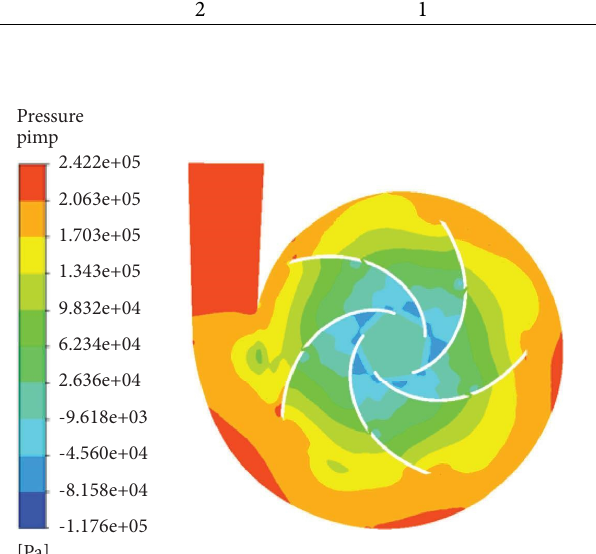
Figure 12: Optimized pressure nephogram.